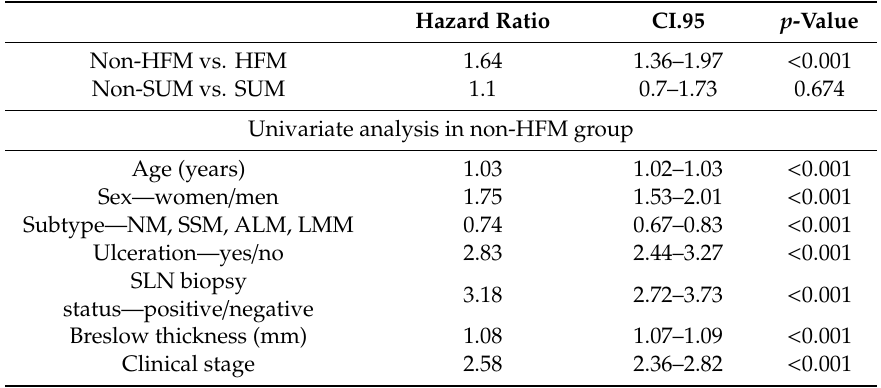
Table 4. Univariate analysis of association clinicopathological features with overall survival in non-HFM group and HFM